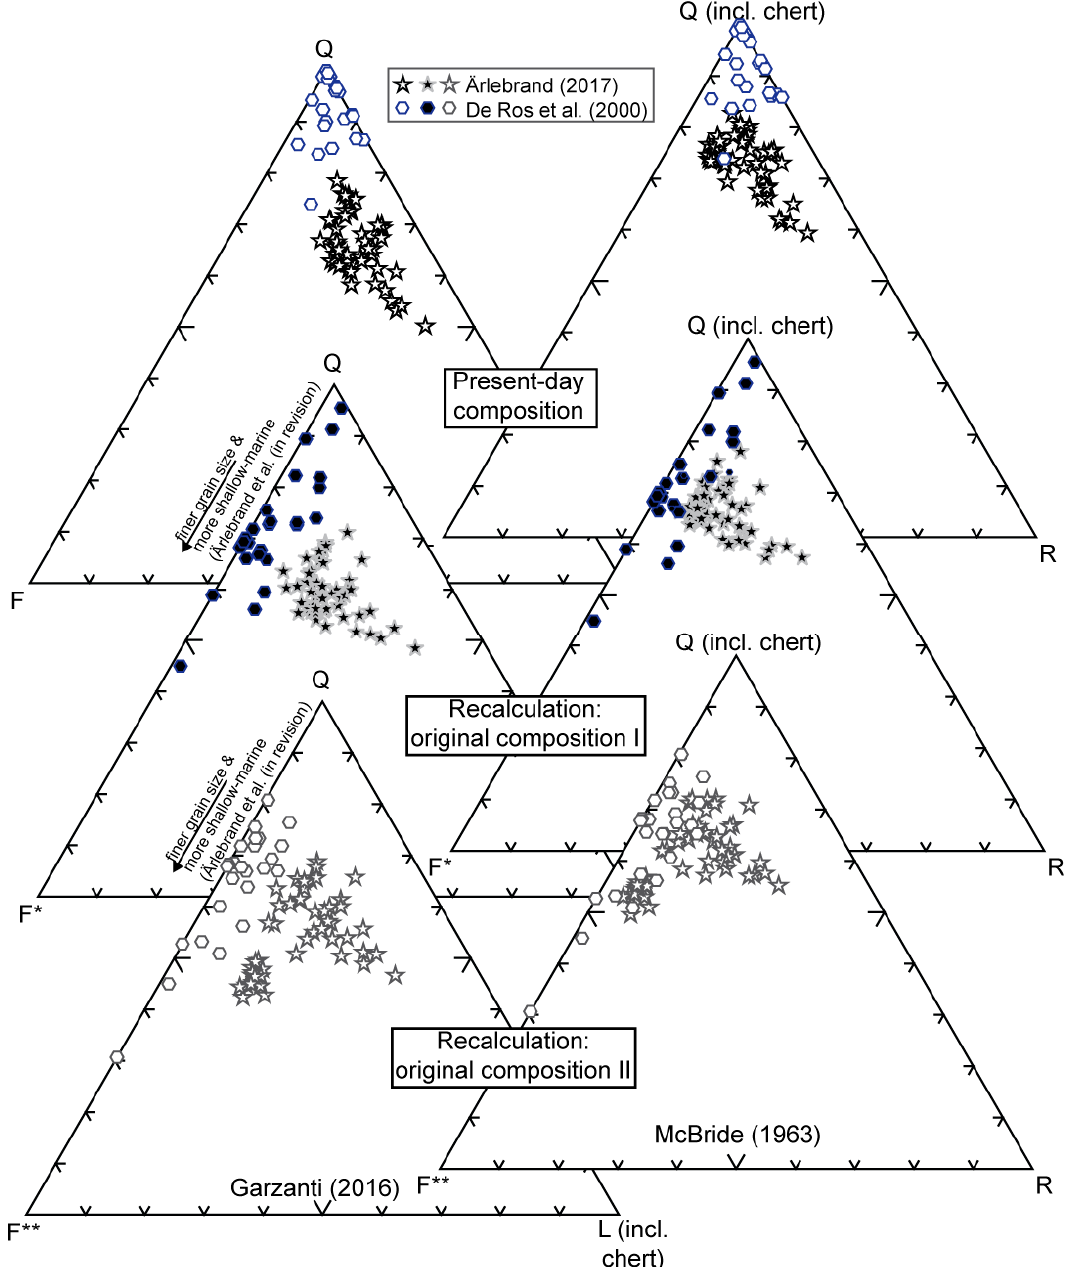
Figure 5. Comparison between present and estimated original compositions in Garzanti’s [23] ( left ) and McBride’s [56] ( right ) classification schemes, but without discrimination lines. Carbonate clasts are included in the lithic-fragment/rock- fragment pool in both cases. * Original composition I includes detrital feldspar, as well as feldspar cement, kaolinite, and intragranular/secondary porosity in the feldspar pool. ** Original composition II includes detrital feldspar, as well as feld- spar cement, kaolinite, illite, and intragranular/secondary porosity in the feldspar pool. F: feldspar; L: lithic fragments; Q: quartz (both monocrystalline and polycrystalline grains); R: rock fragments.